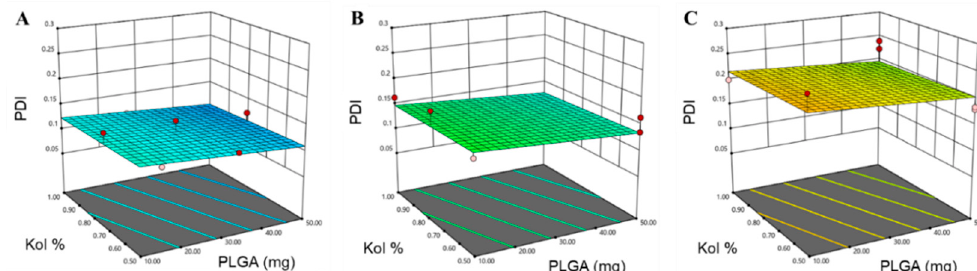
Figure 2. Response surface plots for the effect of the amount of PLGA (mg) and Kol % ( w / v ) on PDI, using ( A ) PLGA-7K, ( B ) PLGA-24K and ( C ) PLGA-38K. using ( A ) PLGA-7K, ( B ) PLGA-24K and ( C )